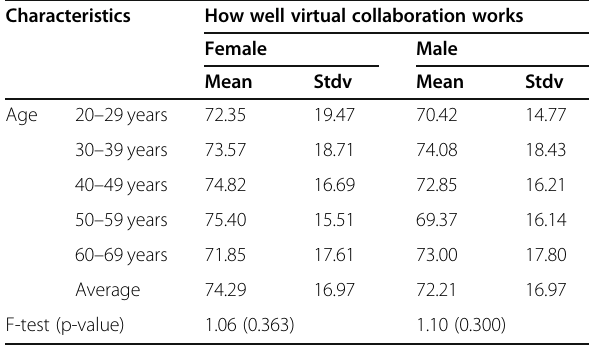
Table 10 Responses to the Question ‘ How Well Do You Think That Virtual Collaboration Has Worked for You in Your Work and for the Projects in Which You Participate (Rating 1-100)? ’